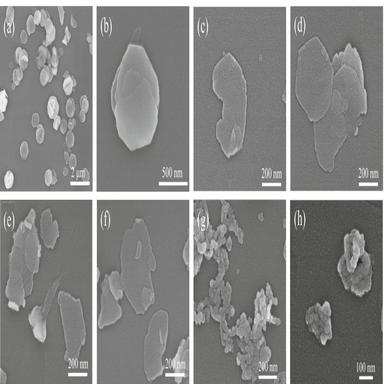
SEM images of (a-b) Cu-IM, (c-d) Co-MOF, (e-f) Cu-IM/Co-MOF, (g-h) Cu-IM/Co-MOF 250.